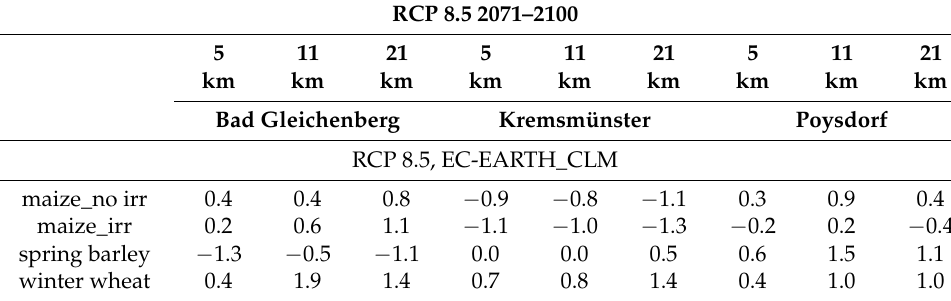
Table 9. Yield differences (%) for maize (rainfed = no irr, optimally irrigated = irr), winter wheat and spring barley (rainfed) grown on the sandy soil class 1; 1 km input data vs. 5, 11, and 21 km aggregated datasets for five ÖKS15 projections RCP 8.5 (EC-Earth_CLM, EC-Earth_RACMO, IPSL_WRF, IPSL_RCA, and HadGEM_RCA) for Bad Gleichenberg, Kremsmünster, and Poysdorf for the 2071–2100 period. Differences in percentages compared with the results with a 1 km